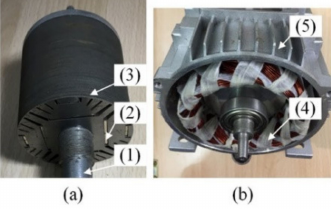
Figure 12. IPMSM. ( a ): Rotor; ( b ): Installation diagram. (1) Motor shaft; (2) Permanent magnet; (3) Rotor lamination; (4) Stator winding; (5) IPMSM body.